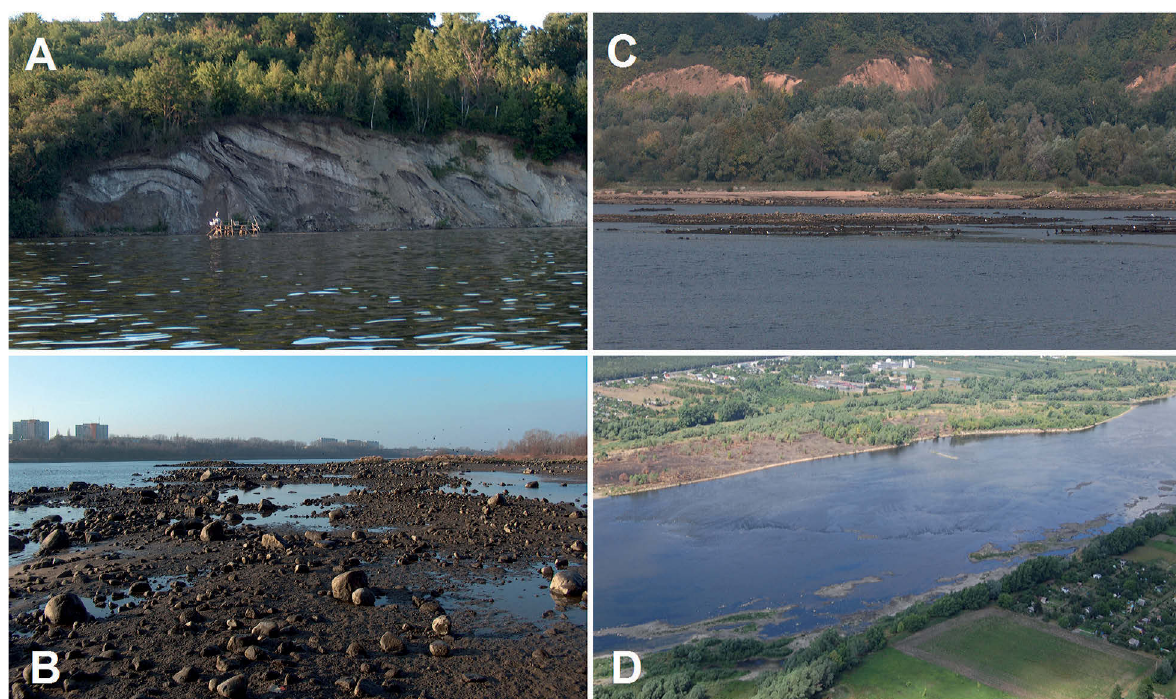
Fig. 2. Geological structures of selected sections of the Vistula between Wloclawek and Torun: A – deformed the Miocene formations (sands and lignite) in the vicinity of Dobrzyń on the Vistula River (Wloclawek Reservoir); B – stones and boul- ders lying on Pliocene clays in the area Grodzka Island (Kępa Grodzka) in Wloclawek (681+100 km); C – Dobrzyń Moraine Plateau edge and emergent clay and stones in the vicinity of the dam in Wloclawek (675+300 km); D – the sill across the river channel in the vicinity Łęg Witoszyn (683+00